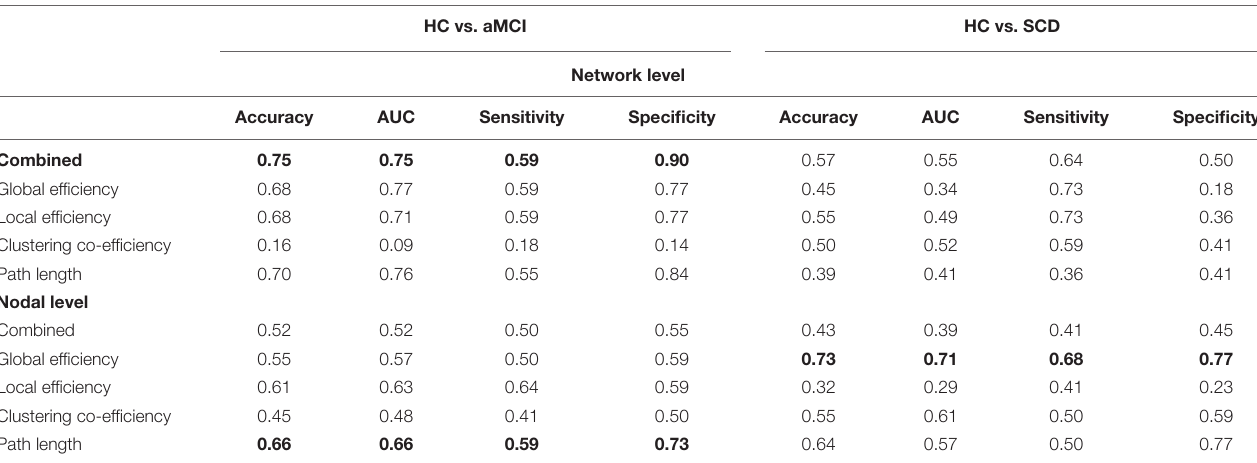
TABLE 2 | Clustering performance based on each